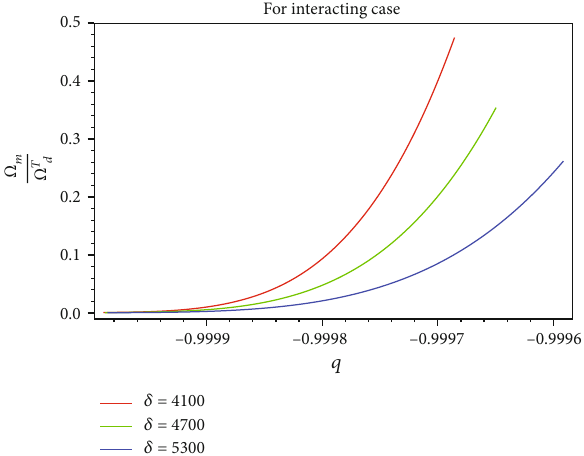
Figure 11: Plot of EoS parameter ω T